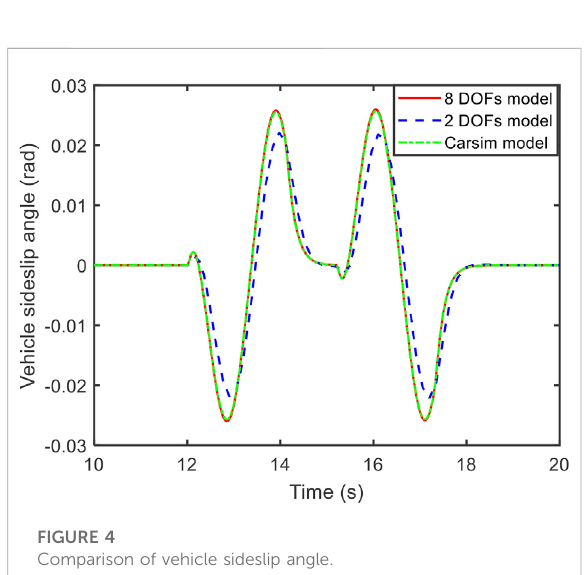
FIGURE 4 Comparison of vehicle sideslip